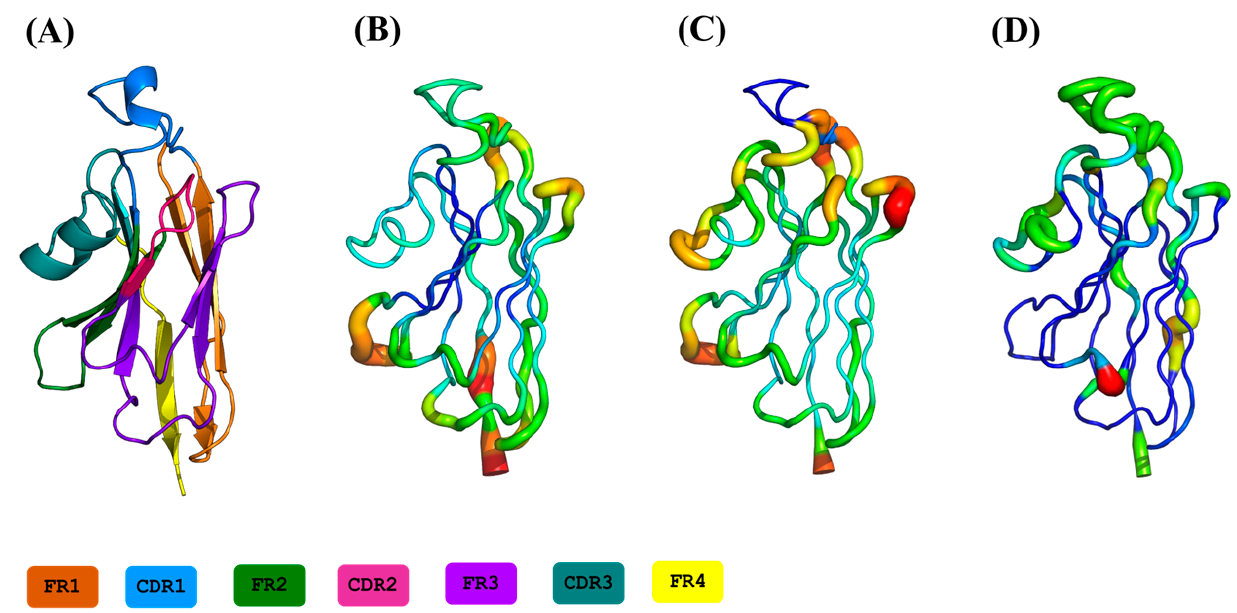
Figure 4. Representation of mean values of flexibility metrics onto a 3D structure of a V H H. ( A ) coloured FRs and CDRs, ( B ) mean normalised C α B-factor values, ( C ) mean C α RMSF values and ( D ) mean N eq values of all V H Hs.